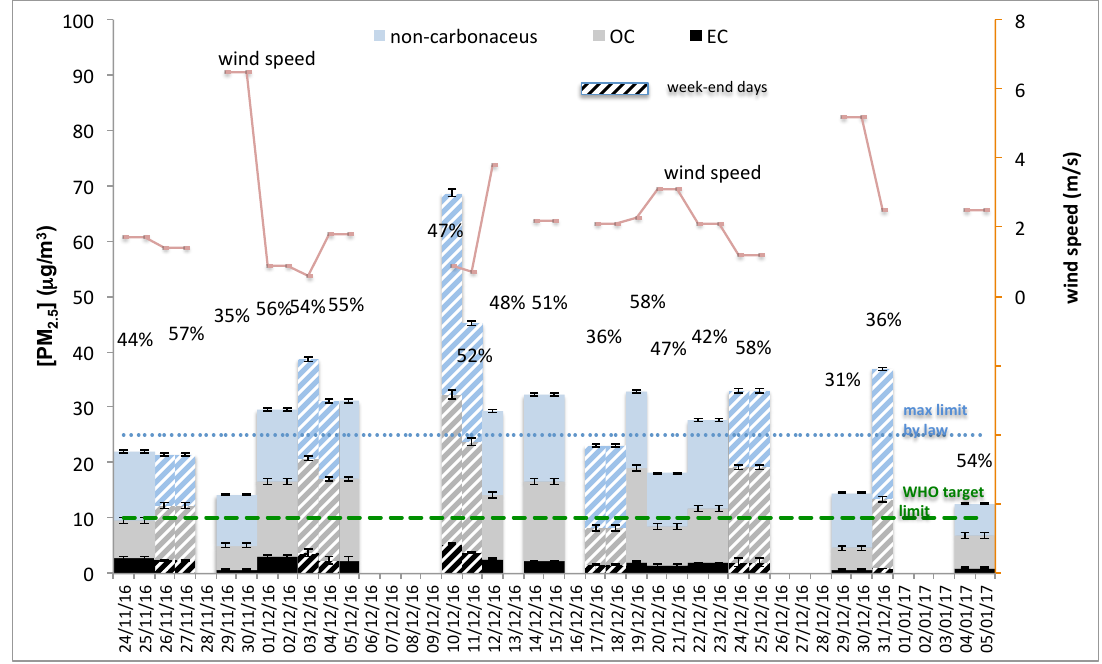
Figure 3. PM 2.5 concentrations, as total (full height bars) and its fractions: OC (grey), EC (black) and all other species not bearing carbon (light blue). The TC fraction of total PM has been reported on the plot for each sample as black figures (%). Average wind speed has been reported on the secondary scale for comparison. Weekend days have been highlighted by stripes on the bars.